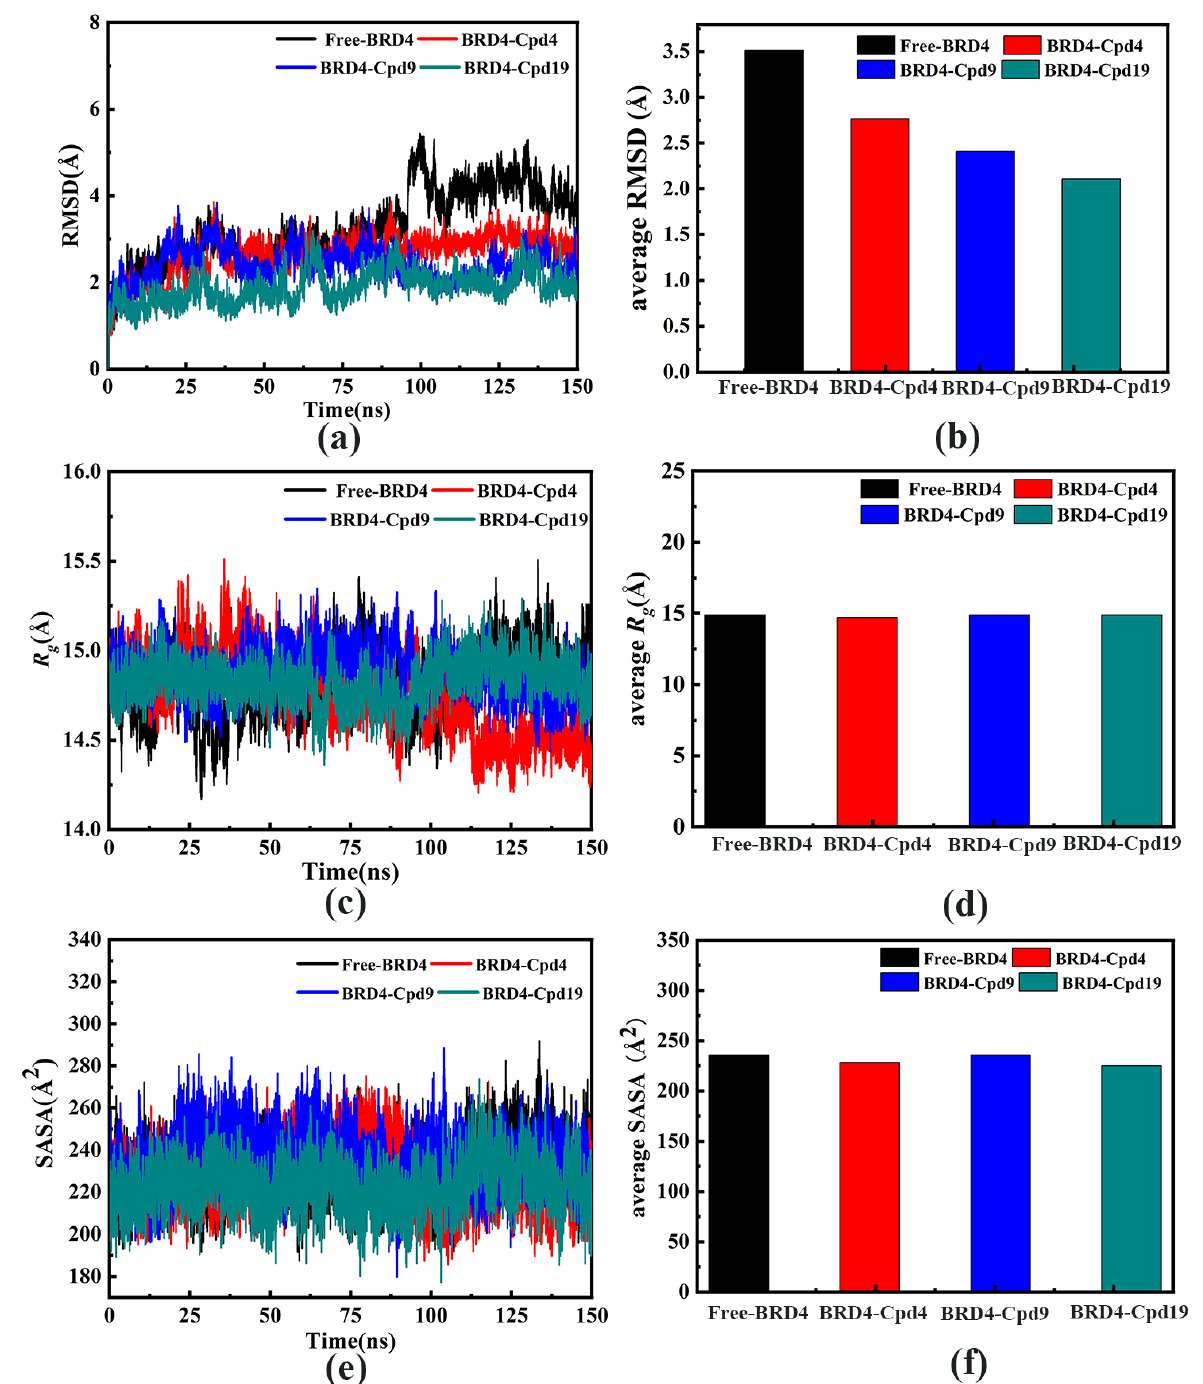
Figure 3. ( a ) Root-mean-square deviation (RMSD) for the backbone atoms, ( b ) the average RMSD of the four systems, ( c ) Radius-of-gyration ( R g ) plot and ( d ) the average R g plot, ( e ) Solvent-accessible-surface-area (SASA) plot ( f ) SASA average plot. The free-BRD4 is represented in black, BRD4-Cpd4 is represented in red, BRD4-Cpd9 is represented in blue and BRD4-Cpd19 is represented in green.